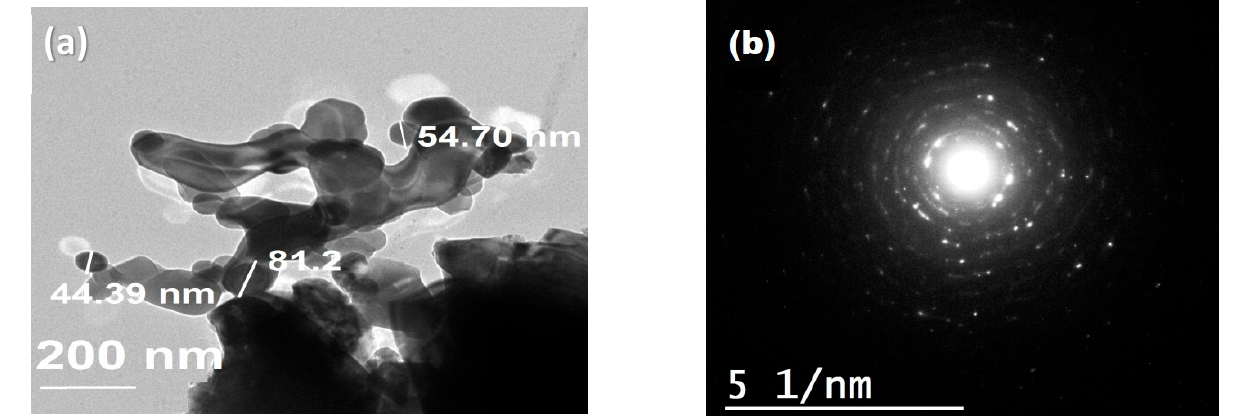
Figure 7. ( a ) TEM and ( b ) SAED pattern of CoFe 2 O 4 .